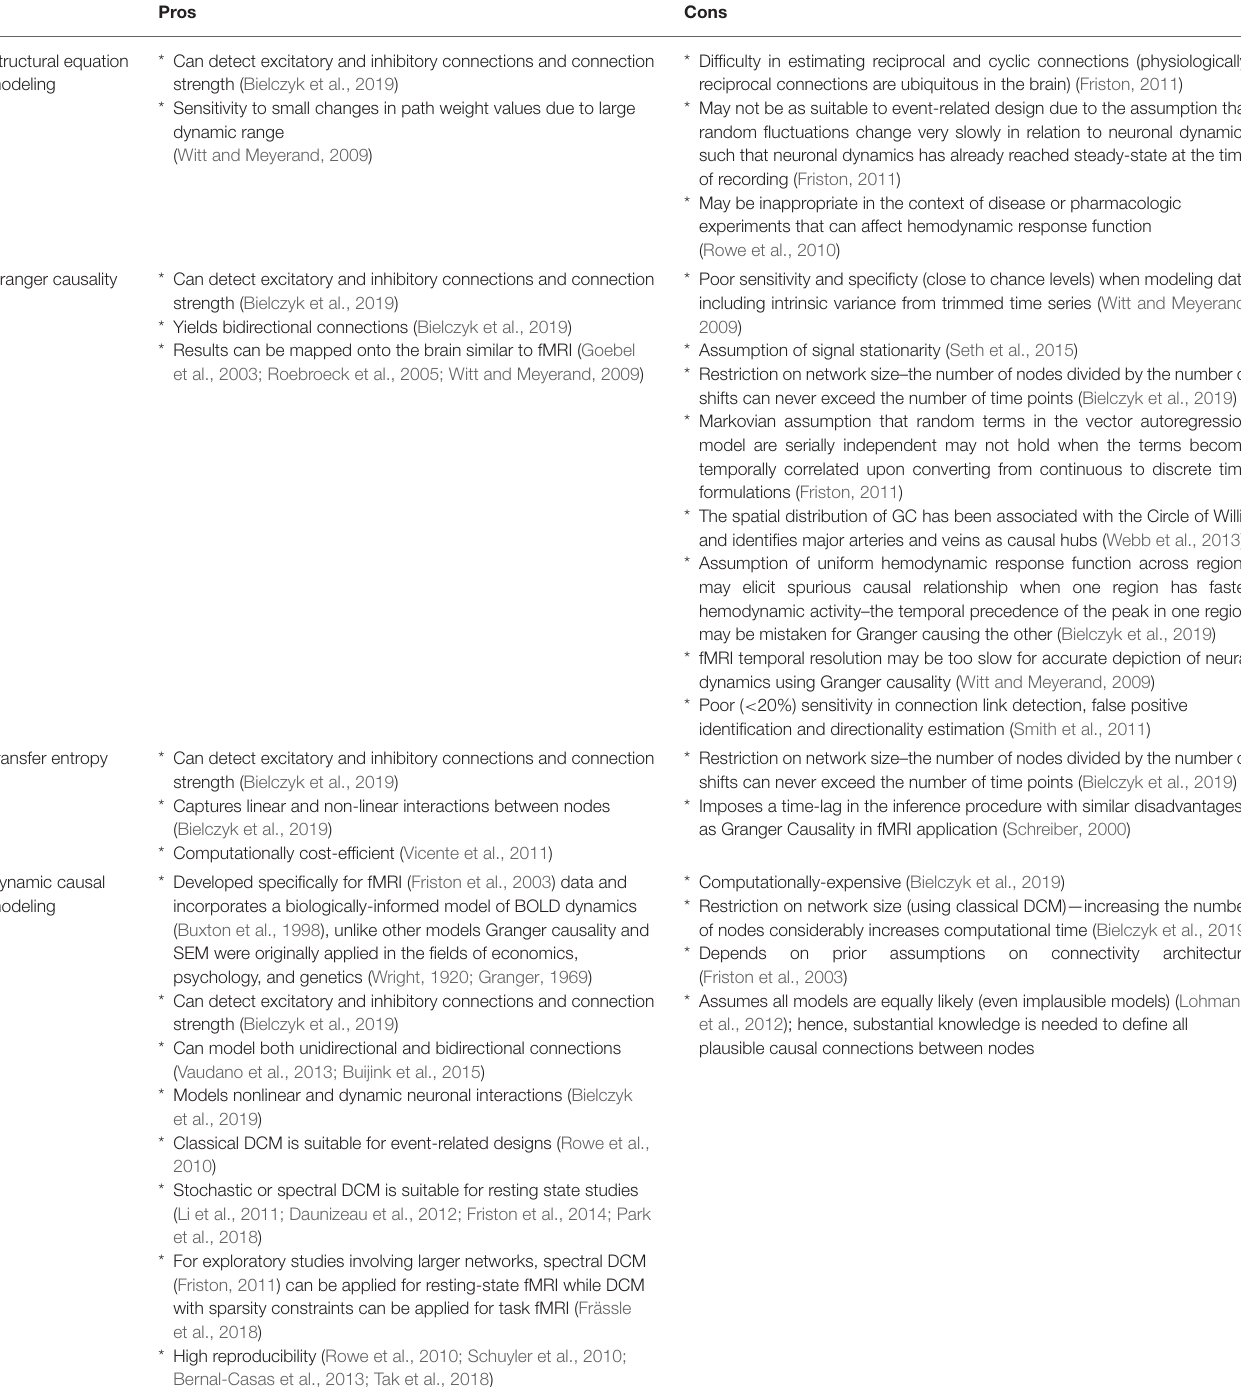
TABLE 1 | Comparison of commonly used effective connectivity models. Pros Cons Structural equation